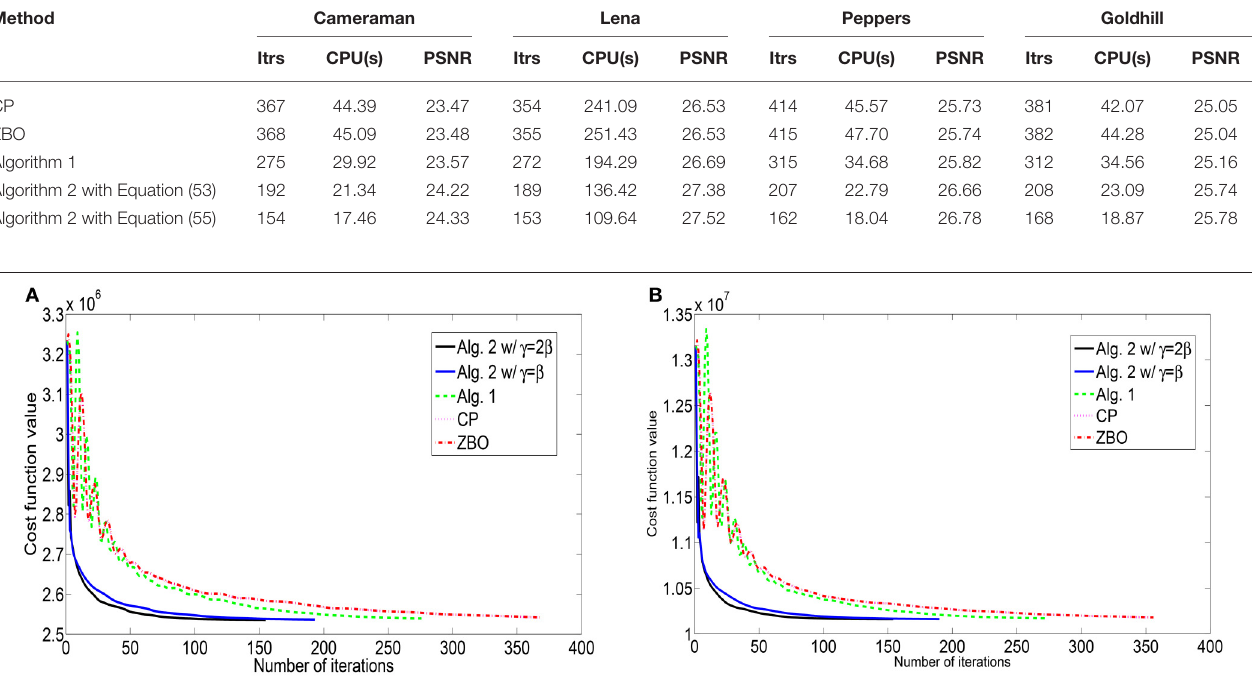
Frontiers in Applied Mathematics and Statistics |